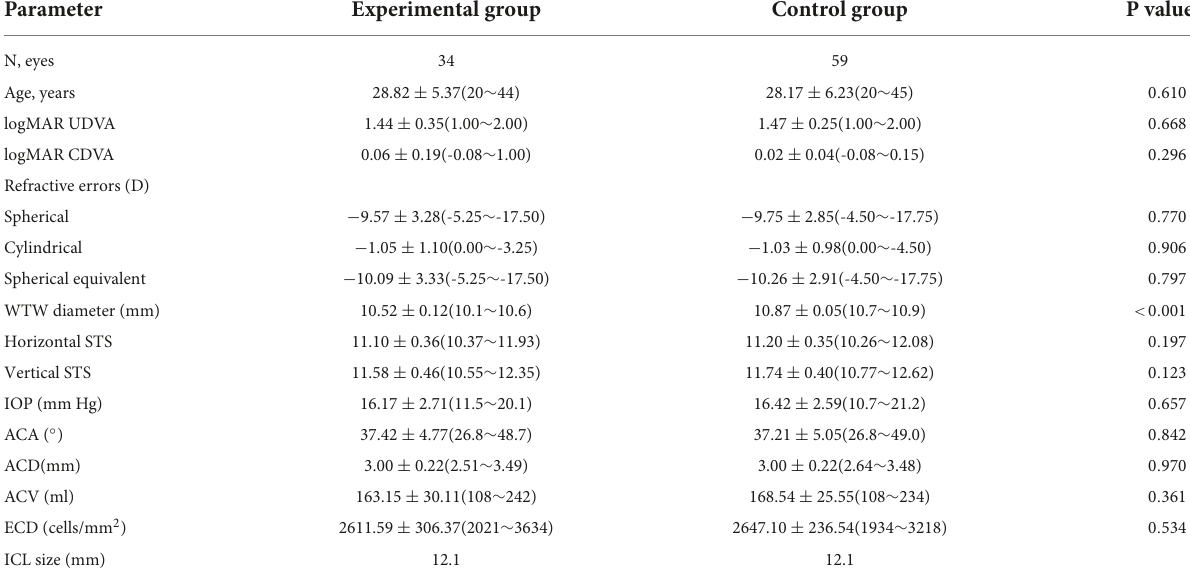
TABLE 1 Distribution of preoperative characteristics.